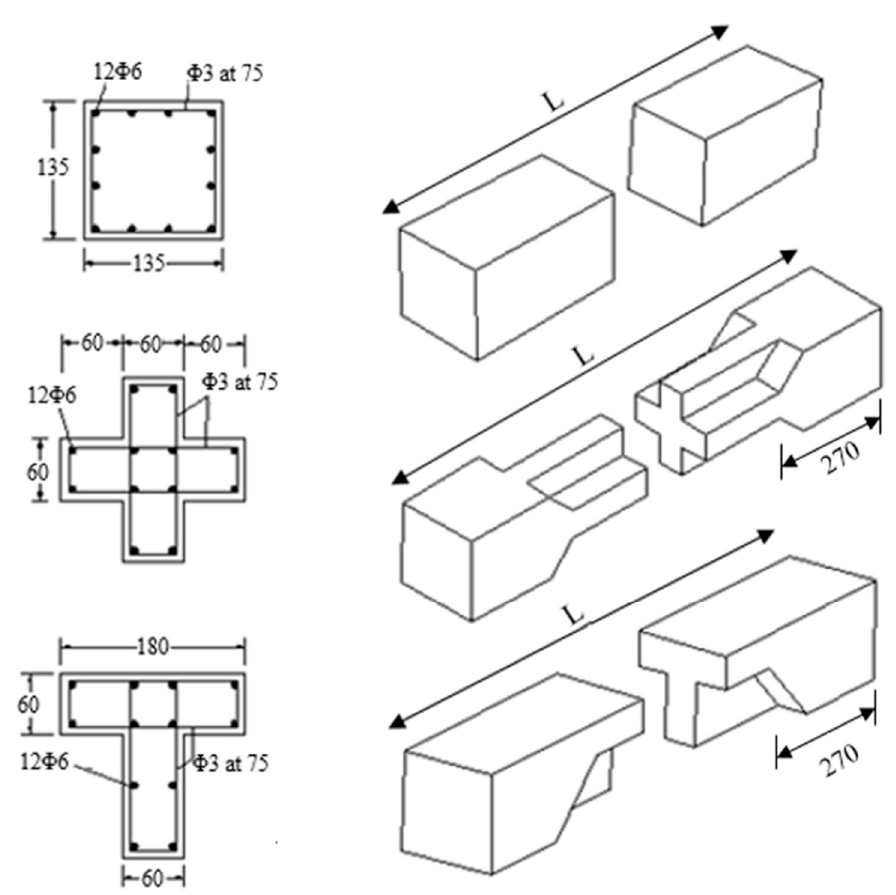
Figure 2. Shapes, dimensions, and reinforced details of reinforced concrete (RC) specimens (dimension in mm).